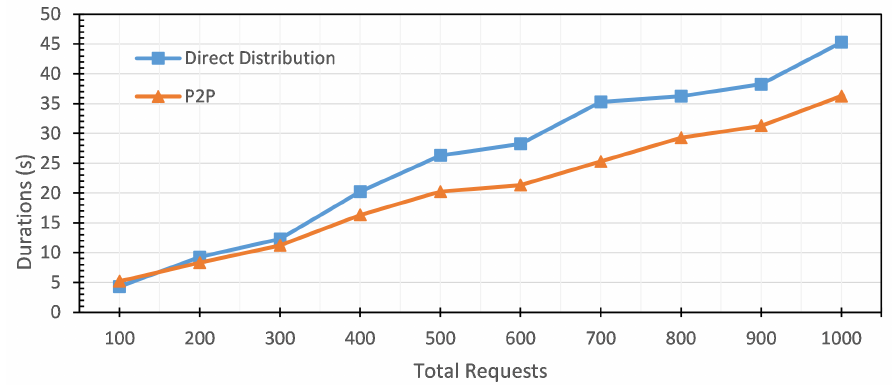
Figure 10. The duration of the Check New Version step: direct firmware update vs. peer-to-peer firmware update.